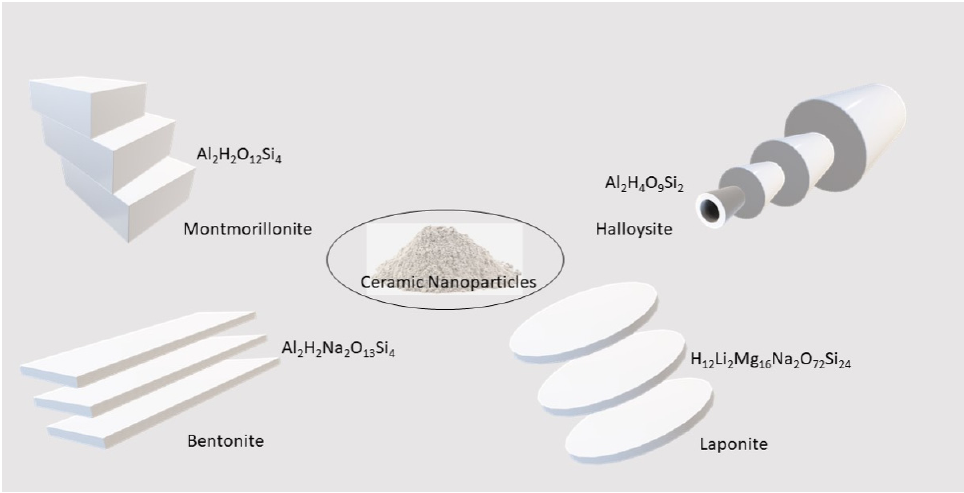
Figure 1. Ceramic nanoparticle types and their morphologies. Table 1. Major types of clay nanoparticles.